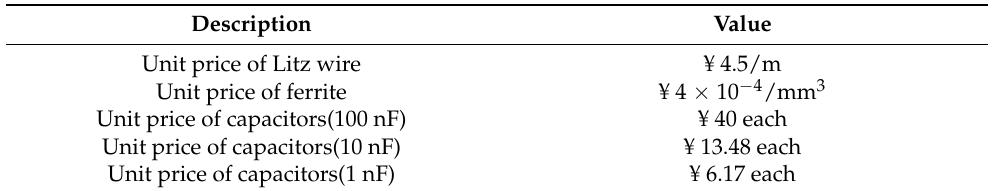
Table 3. Design price variables and